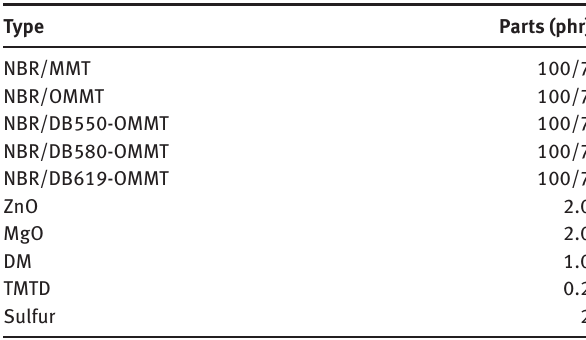
Table 2 The formation of nitrile butadiene rubber (NBR)